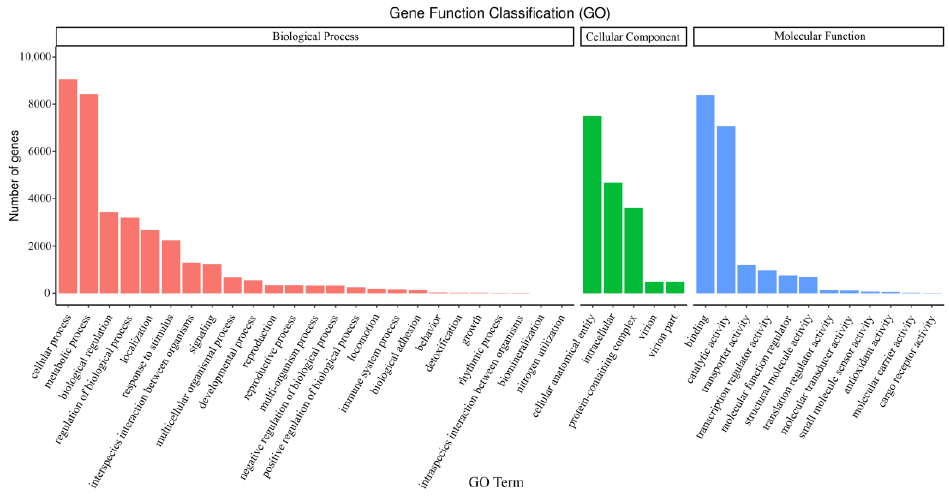
Figure 10. The functional annotation of unigenes in the GO database.